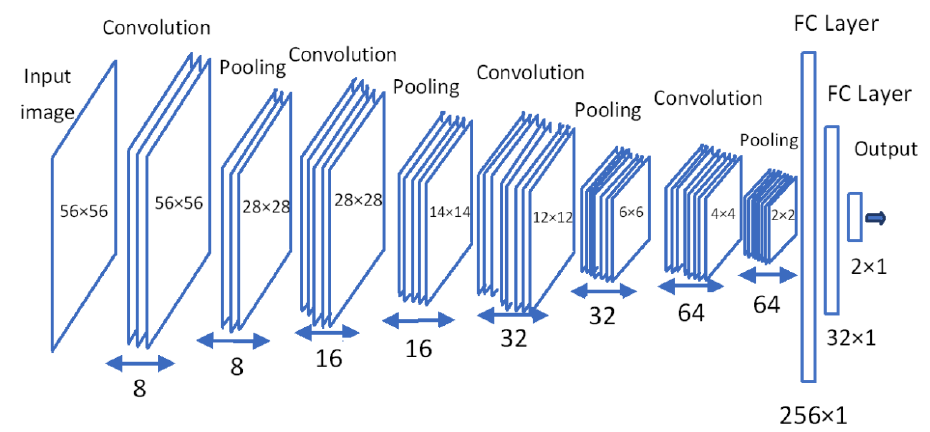
Figure 5. DCNN structure.